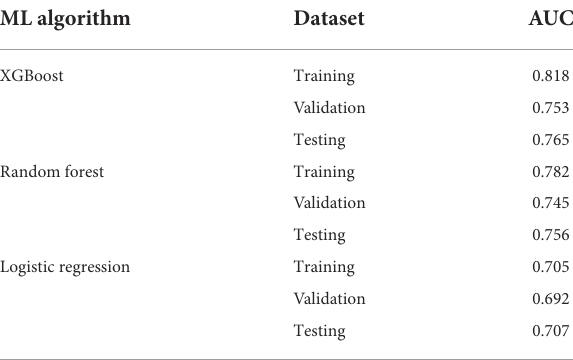
TABLE 4 AUCs for the XGBoost, random forest, and logistic regression models for the training, validation, and testing sets. ML